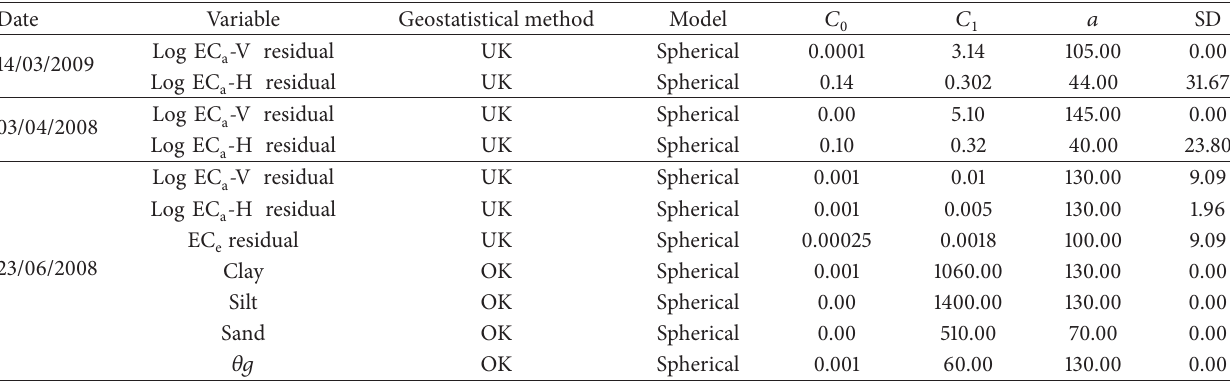
data sets and the soil properties analyzed. a